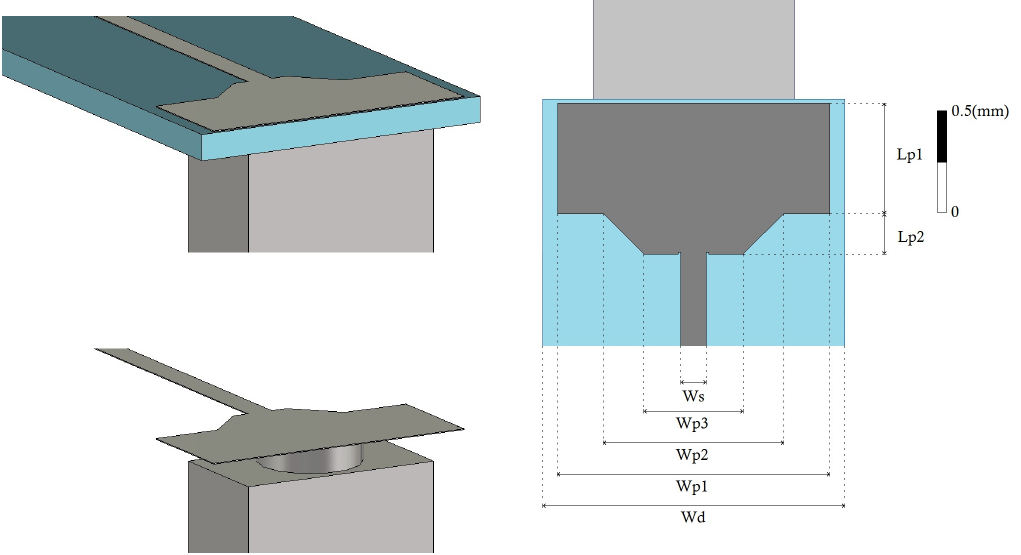
Figure 5. End launcher: via hole configuration with and without the substrate ( left ) and patch geometry ( right